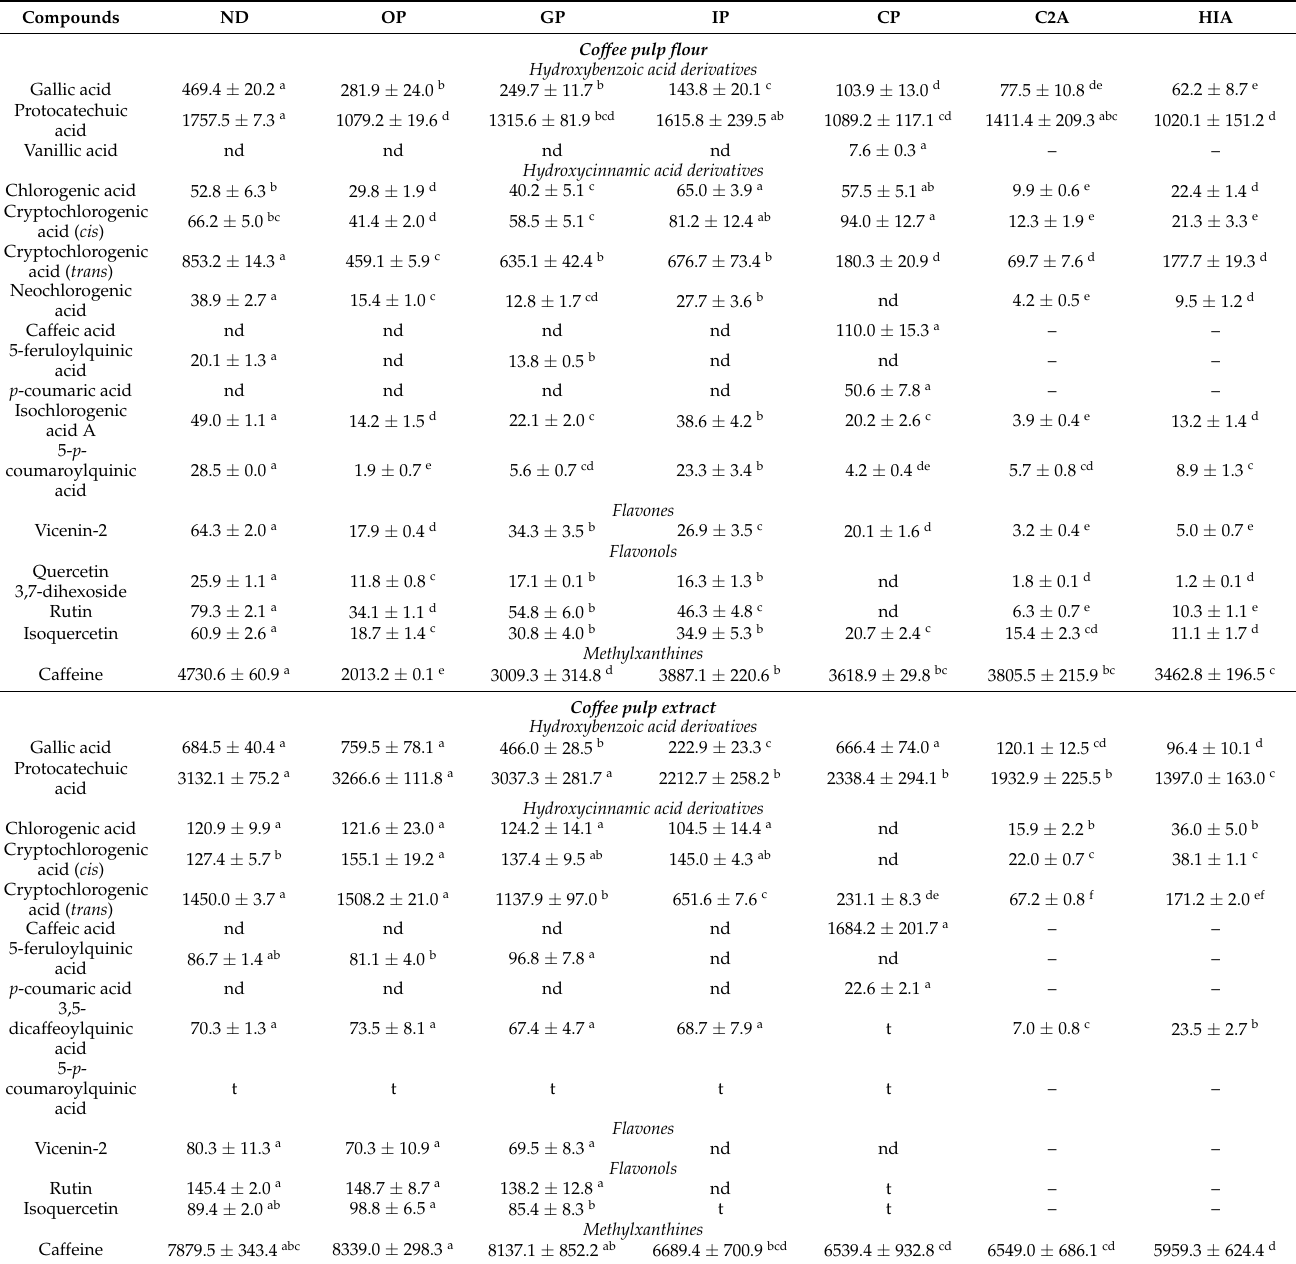
Table 2. Evolution of the concentration of individual phenolic compounds and methylxanthines ( µ g g − 1 ) in the non-digested and digested coffee pulp flour (CPF) and extract (CPE) and its potential Caco-2 and human intestinal absorption throughout the phases of the gastrointestinal